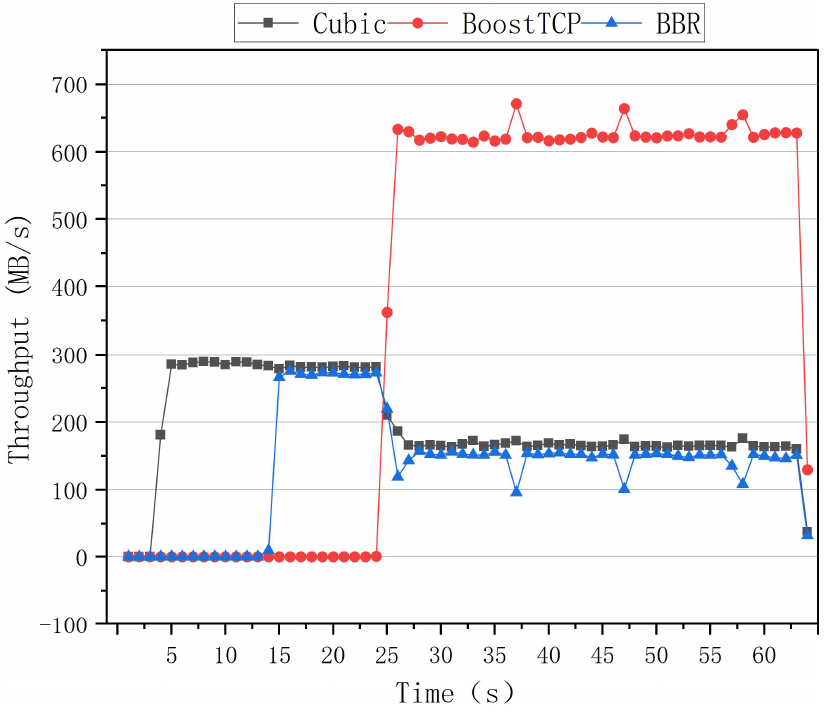
Figure 15. The preemptive test curves of the three congestion control algorithms at a network delay of 80 ms and a packet loss rate of zero.